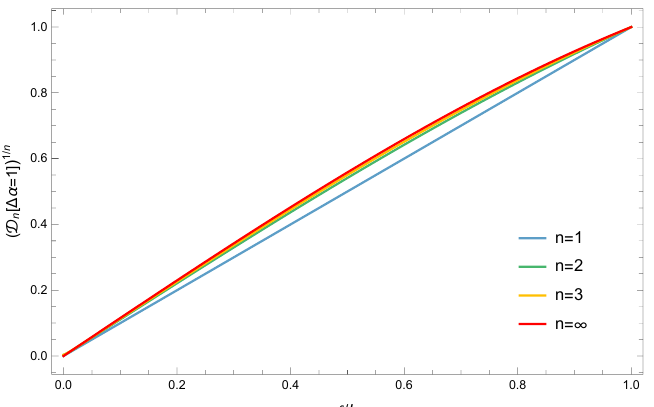
Figure 5 . The scaling functions of the n -distances ( D n [1]) 1 =n as function of ‘=L for n = 1 ; 2 ; 3 ; 1 for two vertex operator states with (cid:1) (cid:11) = 1. Notice the monotonicity of the curves in both n and ‘=L